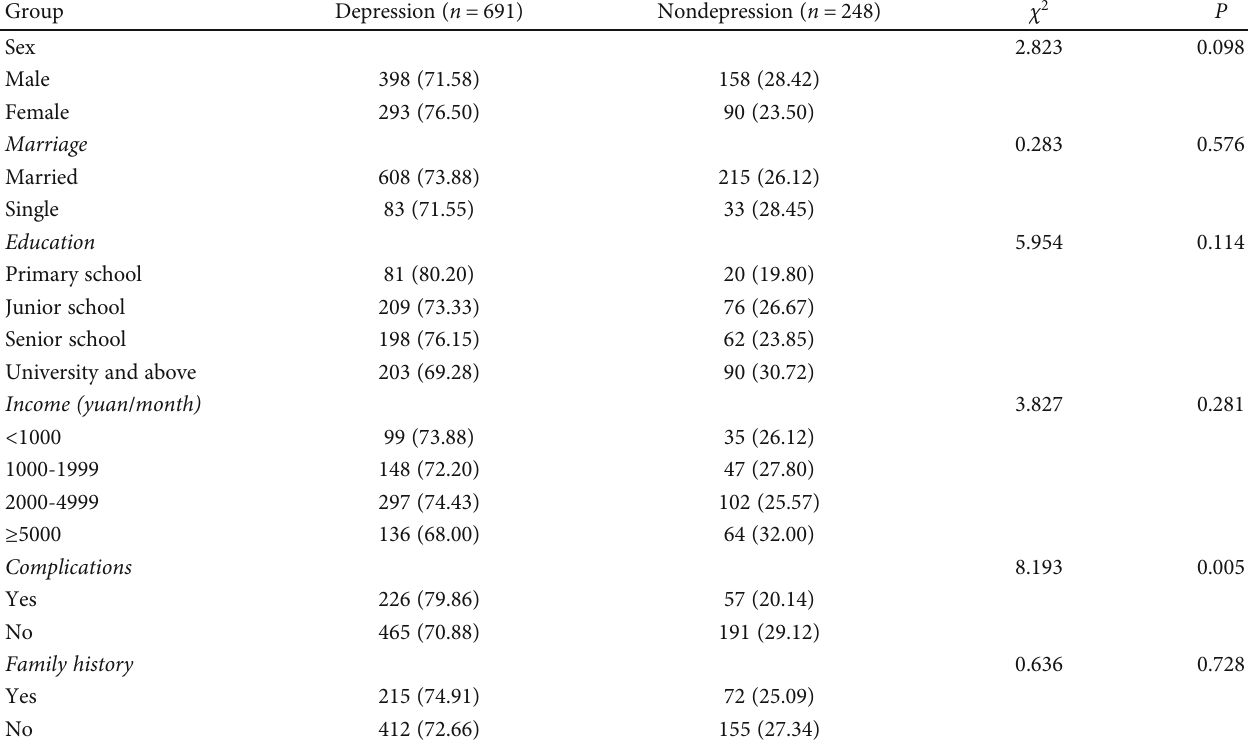
Table 1: Comparison of depressive symptoms between di ff erent patients with diabetes.